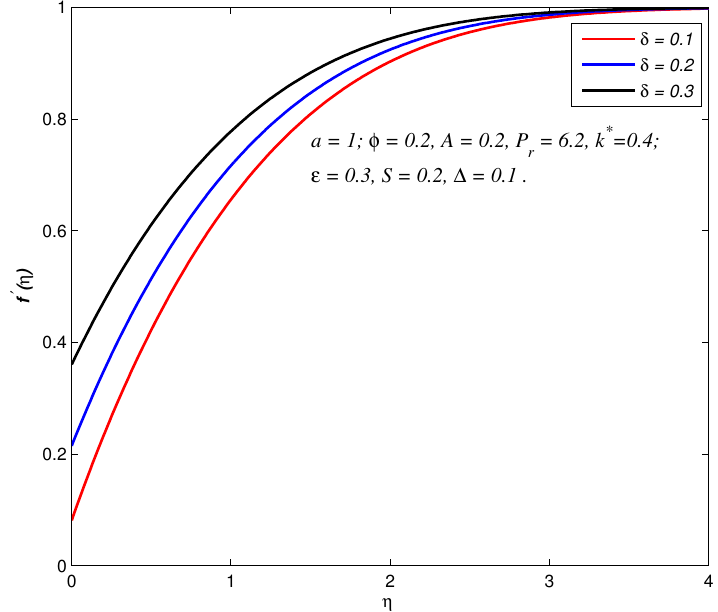
Figure 11. Velocity f (cid:48) ( η ) profiles for different values of velocity slip parameter δ .